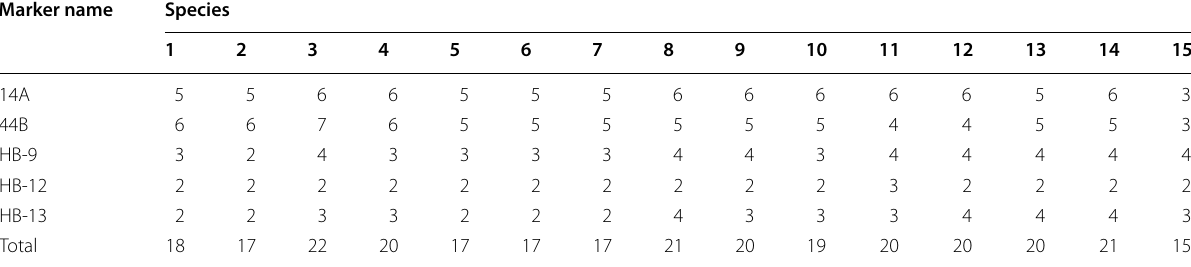
Table 4 Total bands scored by ISSR markers Marker name